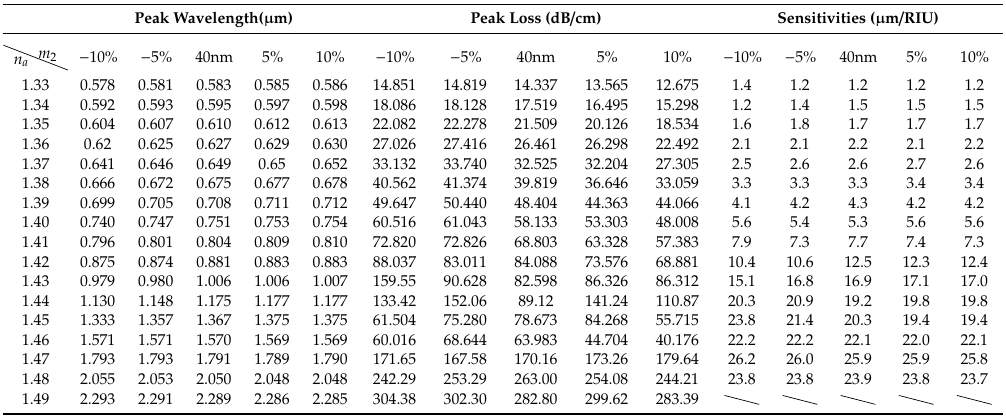
Table 1. Summary of peak wavelengths, peak losses and sensitivities of y -polarized core mode at the n a range of 1.33–1.49, when m 1 is fixed at 40 nm and m 2 changes in the range of ± 10%. Peak Wavelength( µ m) Peak Loss (dB /